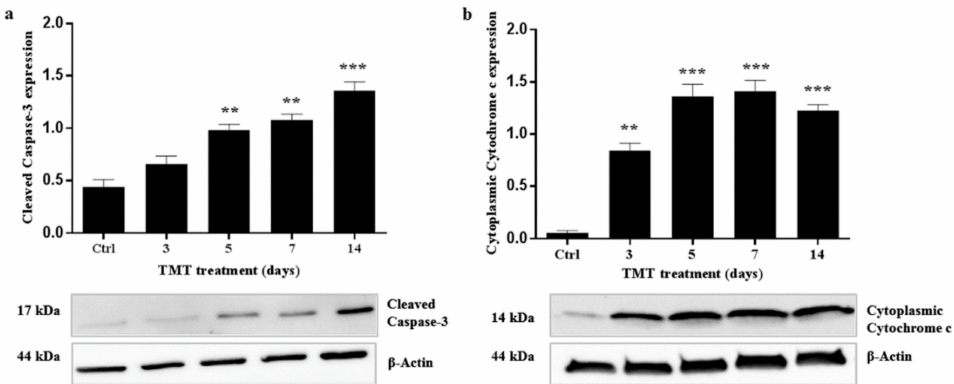
Figure 7. Increased cleaved Caspase-3 and cytoplasmic Cytochrome c expression levels in the rat hippocampus after TMT treatment. Graphic presentations and Western blotting images of cleaved Caspase-3 ( a ) and cytoplasmic Cytochrome c ( b ) proteins are shown. Values are presented as mean ± SEM for each group: the control rats ( n = 3) and rats TMT-treated for 3, 5, 7, and 14 days ( n = 3 / group). ** p < 0.01 and *** p < 0.001 compared with controls, Dunnett’s-test. Ctrl: control